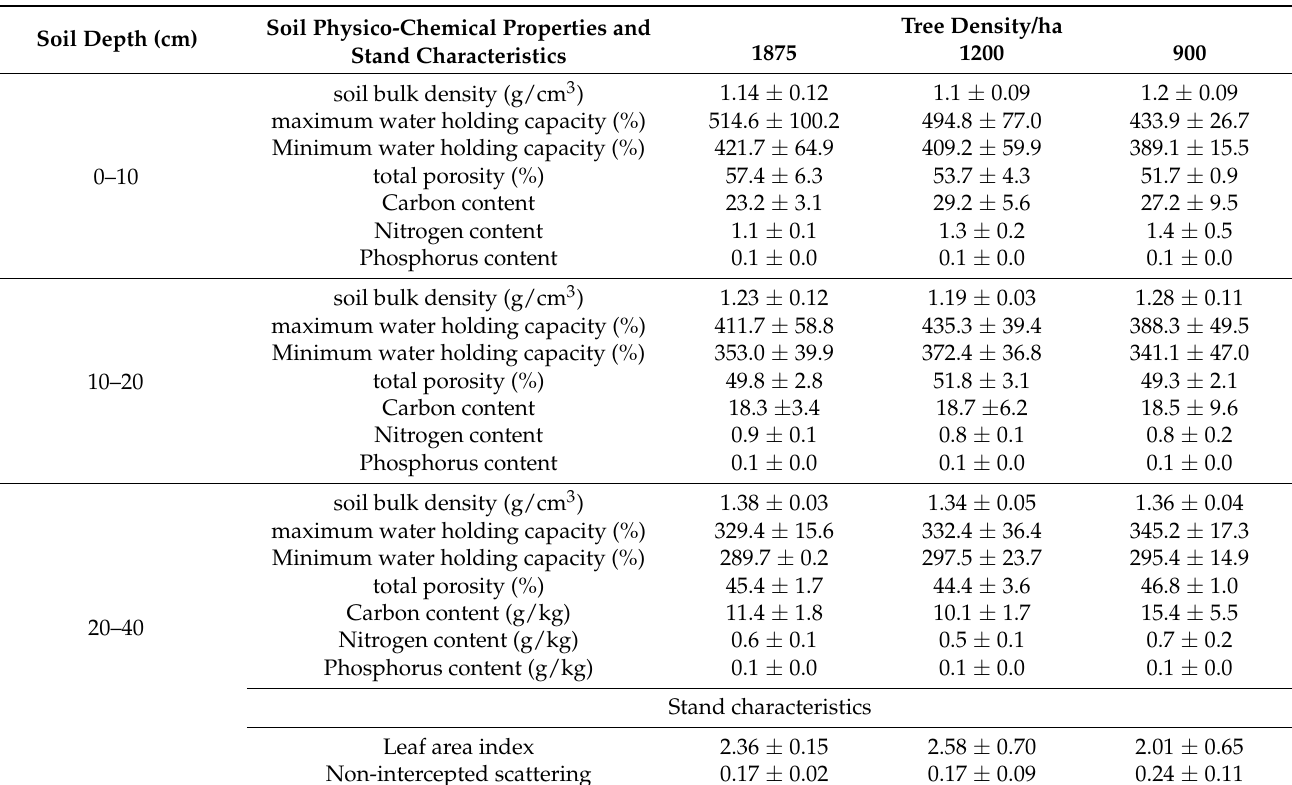
Table 1. Soil physical and chemical properties and stand characteristics of Chinese fir stands (mean ± SE, n =